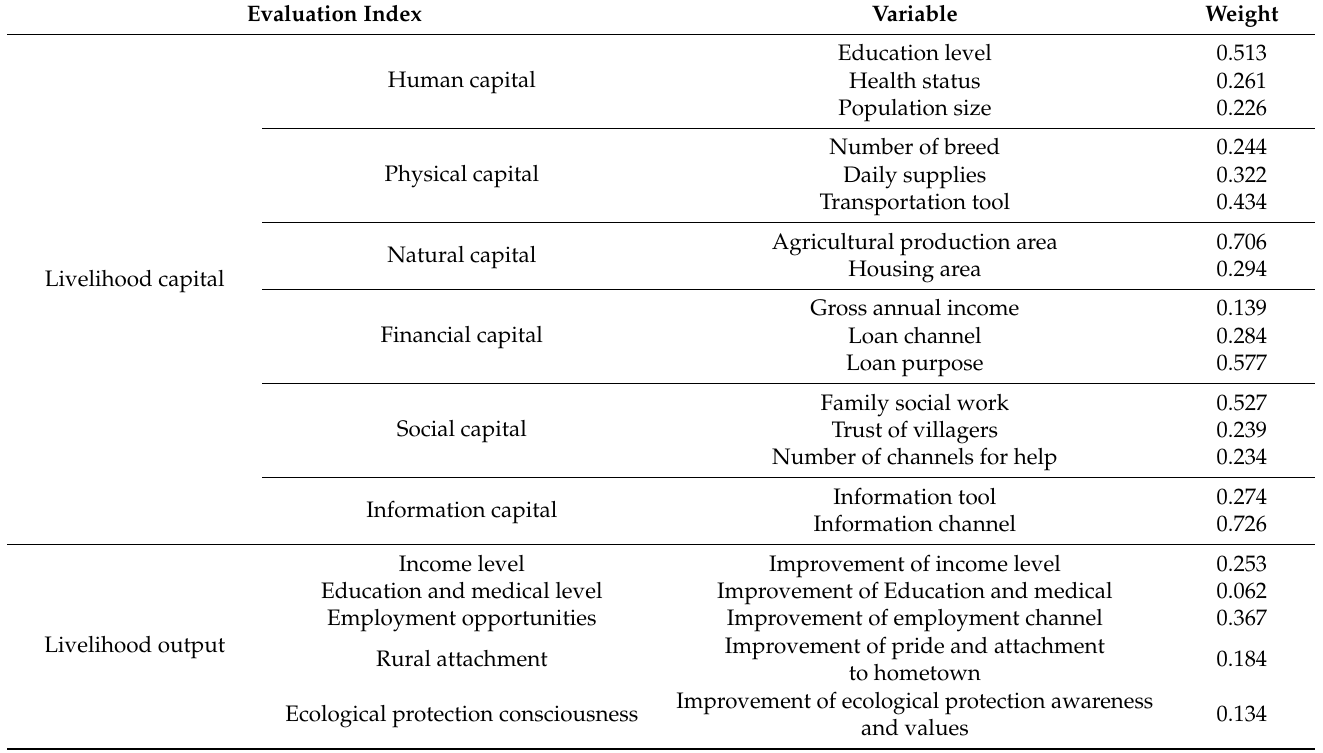
Table 2. Evaluation index system of farmers’ livelihood